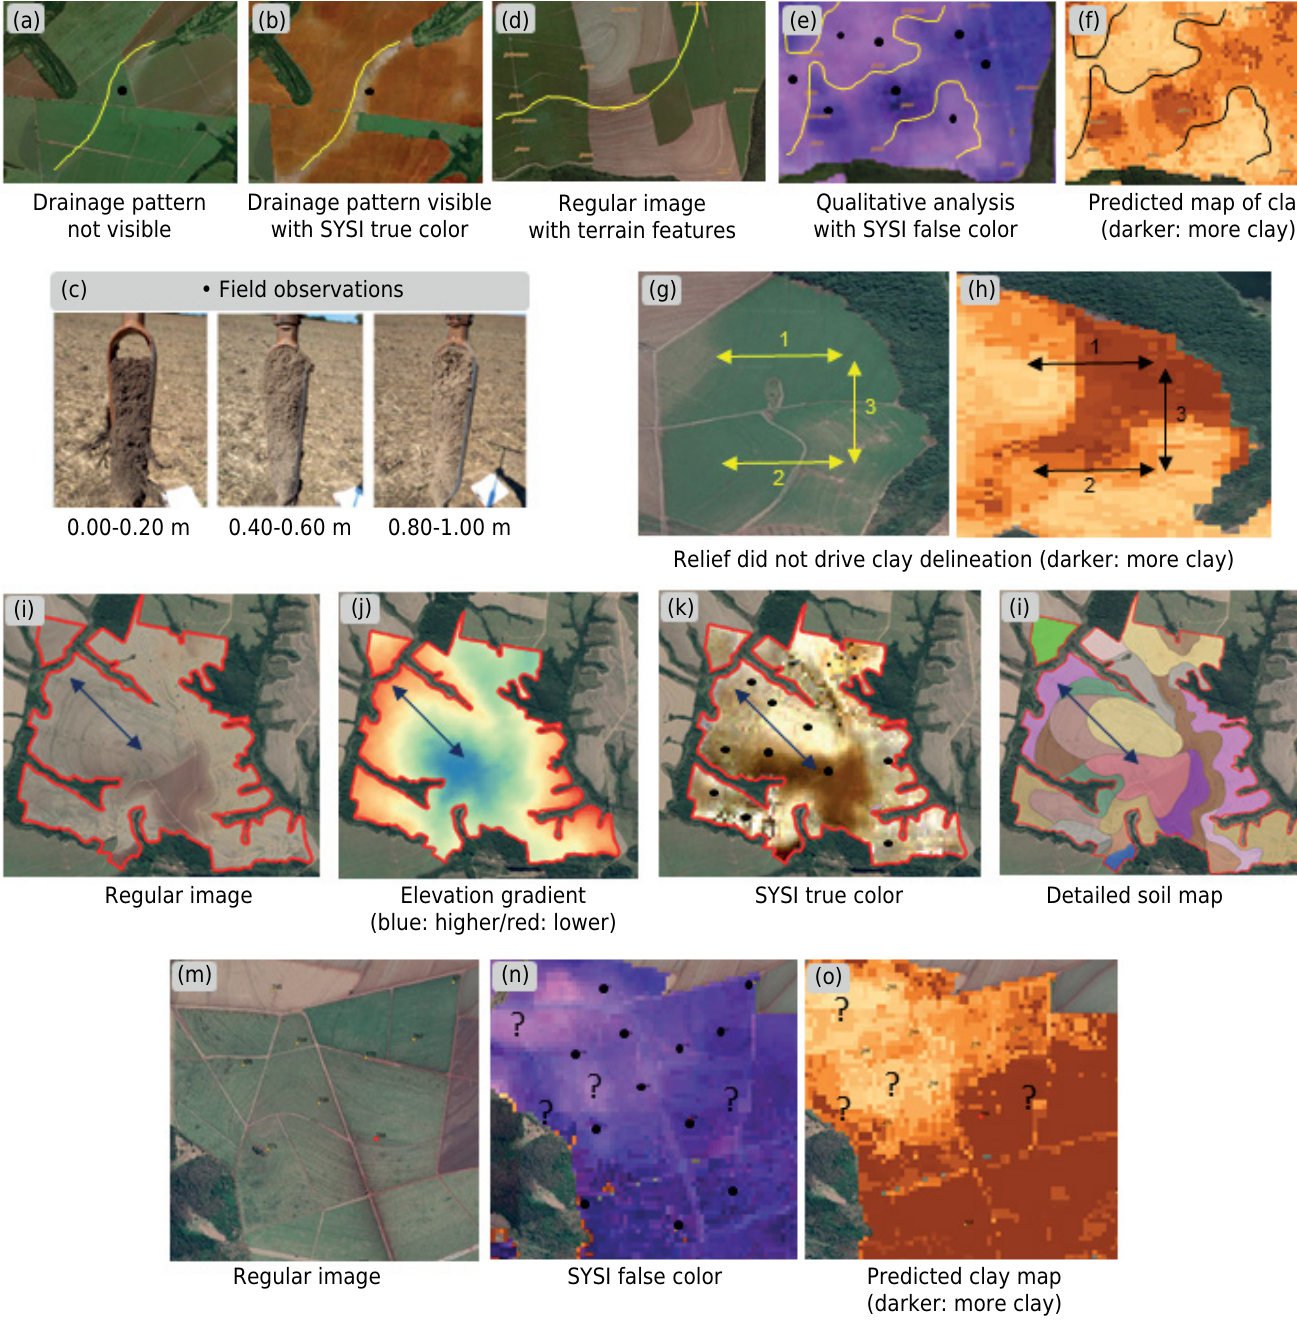
Figure 6. Farm-level illustrations: a) aerial photograph of site 1 (lat: -48.28047, lon: -21.50934), b) SYSI true color of site 1, c) field observation at site 1, d) aerial photograph of site 2 (lat: -48.05636, lon: -22.08765), e) SYSI false color of site 2, f) surface clay content of site 2, g) aerial photograph of site 3 (lat: -48.02316, lon: -22.09264), h) surface clay content of site 3, i) aerial photograph of site 4 (lat: -47.47652, lon: -23.15061), j) digital elevation model of site 4, k) SYSI true color of site 4, l) detailed soil map of site 4, m) aerial photograph of site 5 (lat: -48.29843, lon: -21.90618), n) SYSI false color of site 5, o) surface clay content of site